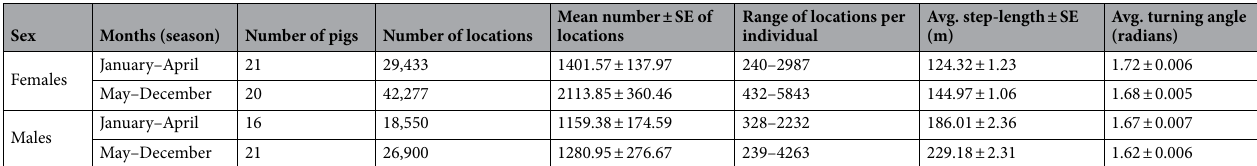
Table 3. Summary of global positioning system (GPS) information, average step-lengths (± SE of the mean parameter) and turning angles of female and male wild pigs ( Sus scrofa ) on the Savannah River Site in